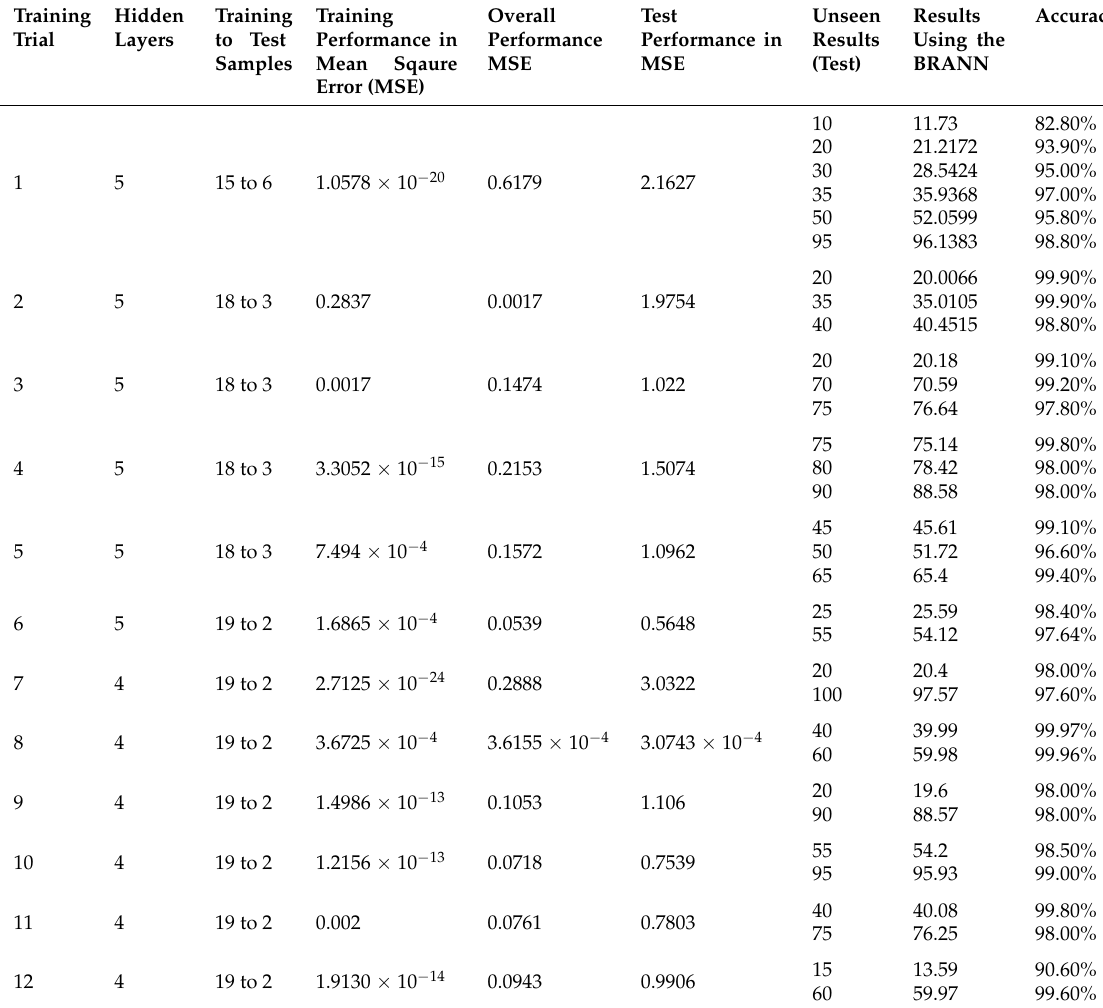
Table 1. The Bayesian regulation backpropagation artificial neural network (BRANN) for characterizing the concentration of a fluid